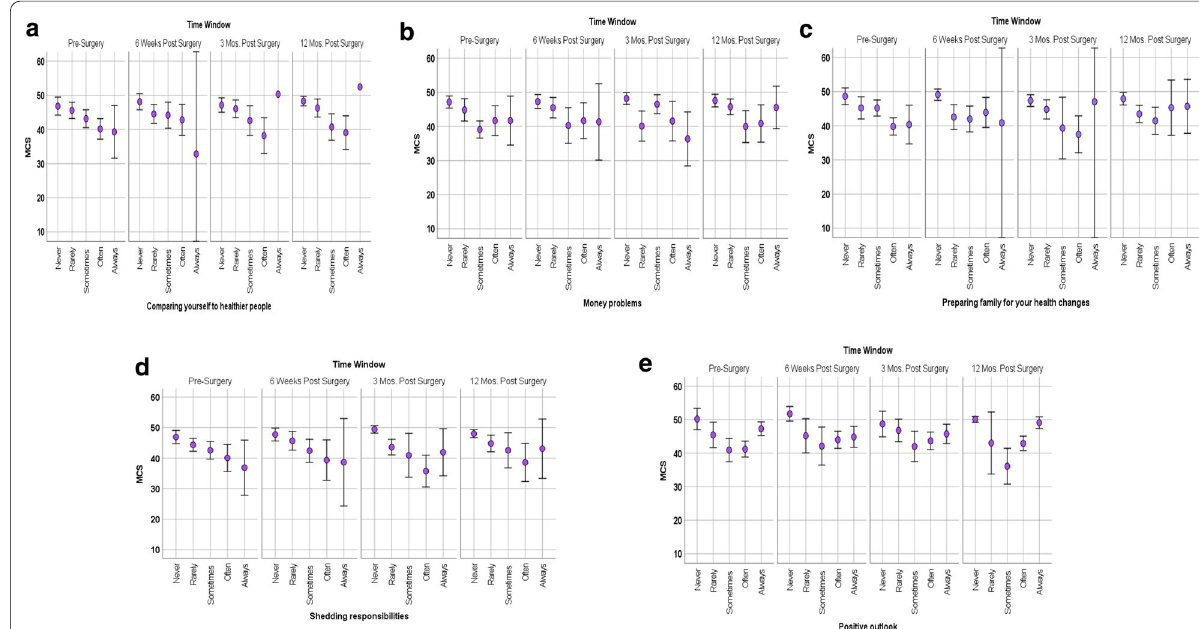
Fig. 4 a – e Main effects of appraisal with MCS over time